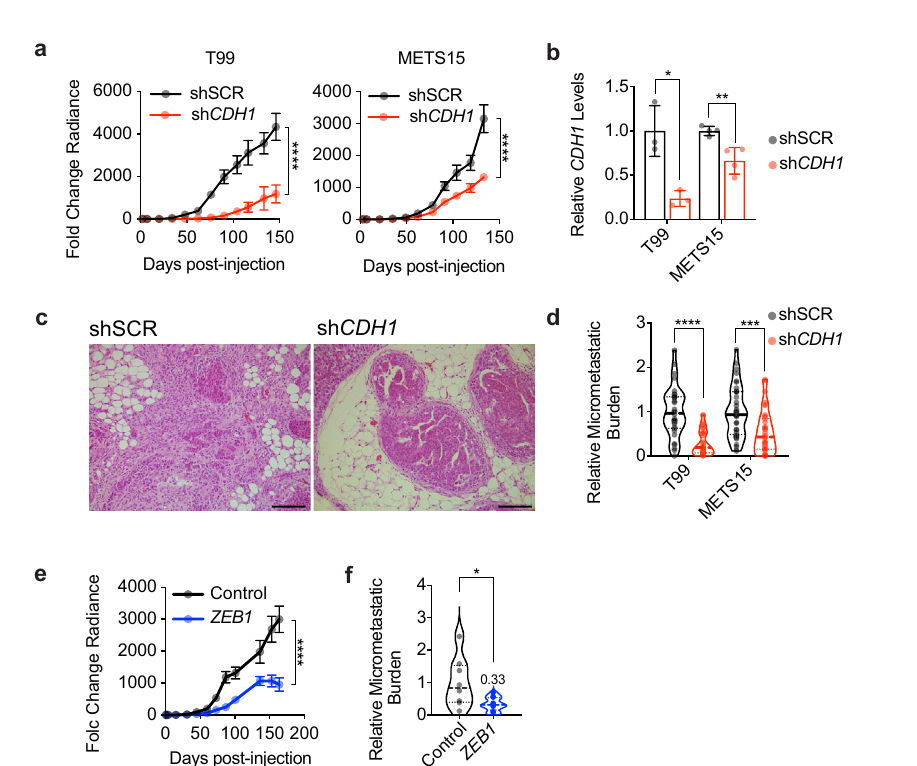
Fig.5|RoleofEMPinER + PDXprogression.a GrowthcurveofintraductalT99and METS15 shSCR or sh CDH1 . Data represent mean±SEM of 16 xenograft glands for each shSCR and sh CDH1 groups for T99 and 16 and 20 xenograft glands, respec- tively,forMETS15,5miceforeachcohort.Two-wayANOVA,multiplecomparisons. b Relative CDH1 expressioninshSCRandsh CDH1 intraductalxenografts(3eachfor T99 and 4 each for METS15). Data represent mean±SD. Unpaired Student ’ s t-test. c Representative H&E micrographs of T99 shSCR and sh CDH1 xenograft glands. Scalebar, 200 µ m. d Violin plot of the relative micro-metastatic burden in T99